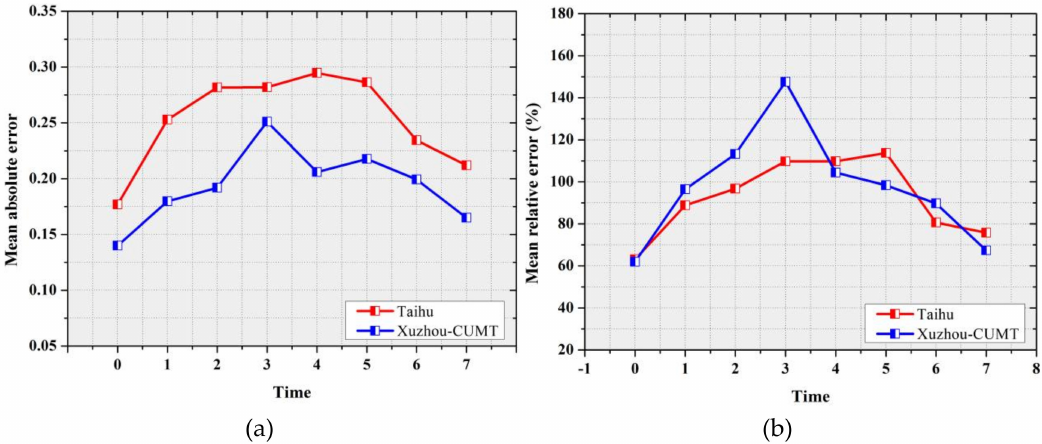
Figure 8. Mean absolute error and mean relative error at eight moments; ( a ) is mean absolute error at eight moments, ( b ) is mean relative error at eight moments.